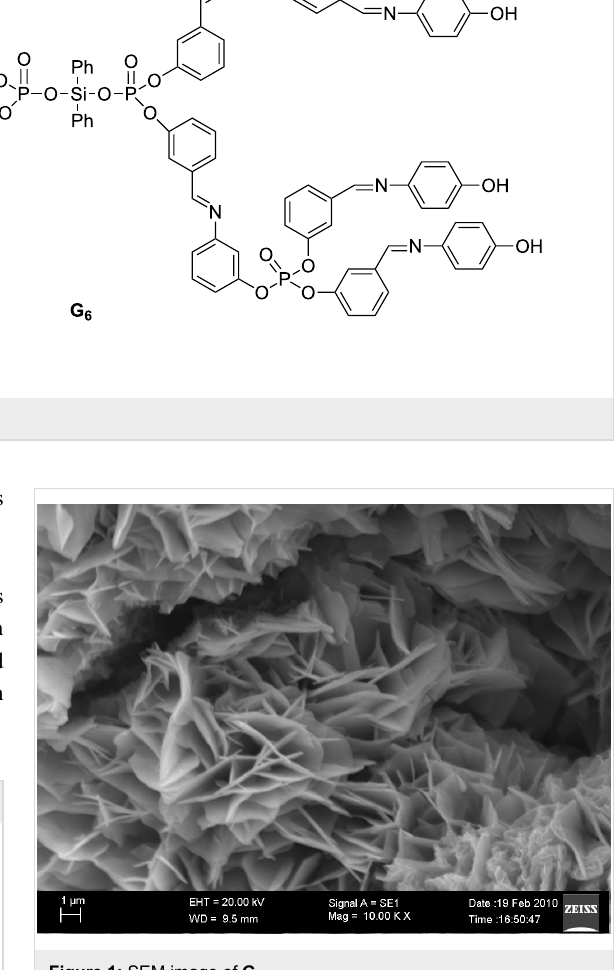
Figure 1: SEM image of G 6